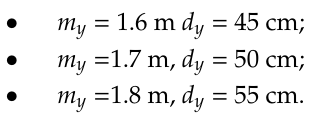
1 , p 2 (a) and p 3 (b) .